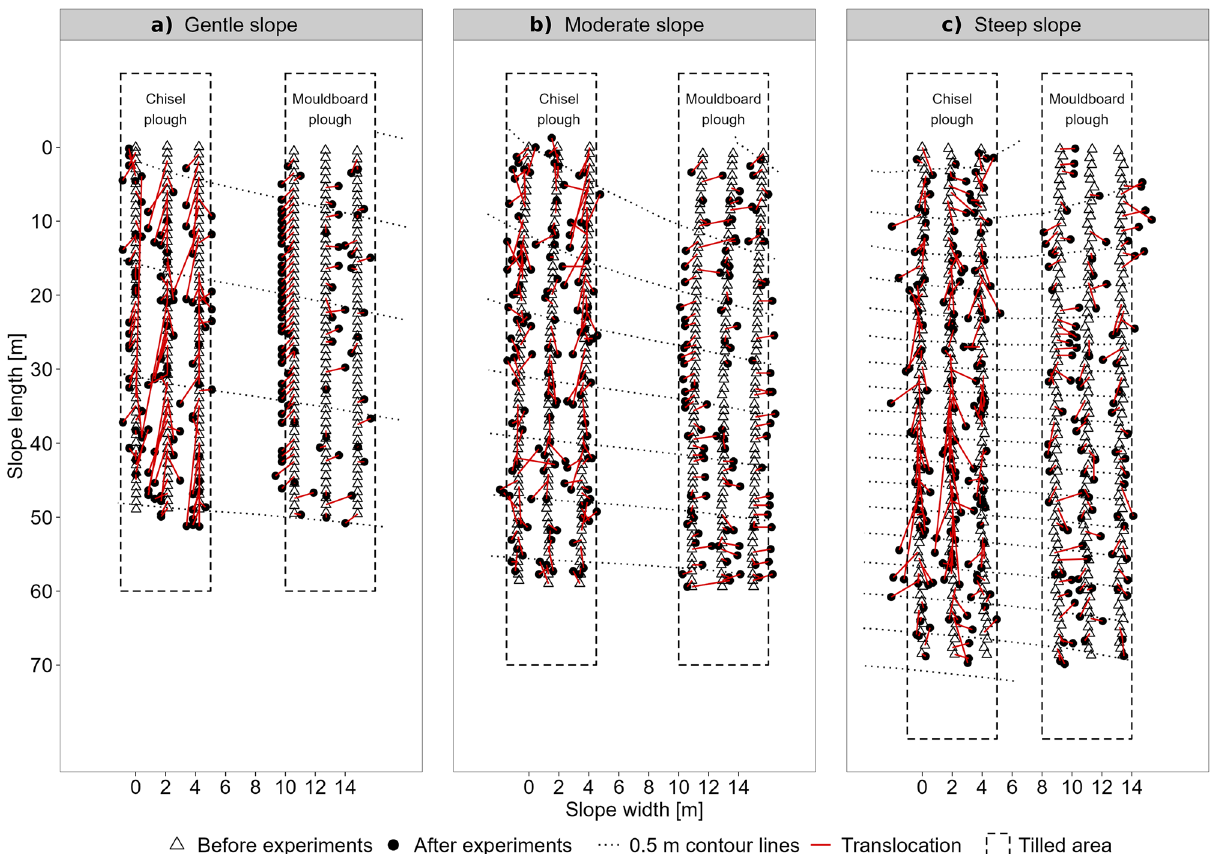
Figure 4. Spatial pattern of the position of the RFIDs before (triangles) and after the experiments (black dots) for the three experimental sites with ( a ) gentle, ( b ) moderate, and ( c ) steep slope. Tillage by chisel plough (left) and mouldboard plough (right), respectively. Red lines indicate the net movement of the individual RFID transponders. Dotted lines indicate contour lines (0.5 m interval) of the digital elevation model and dashed boxes mark the tilled area whereby tillage direction was alternating up- and